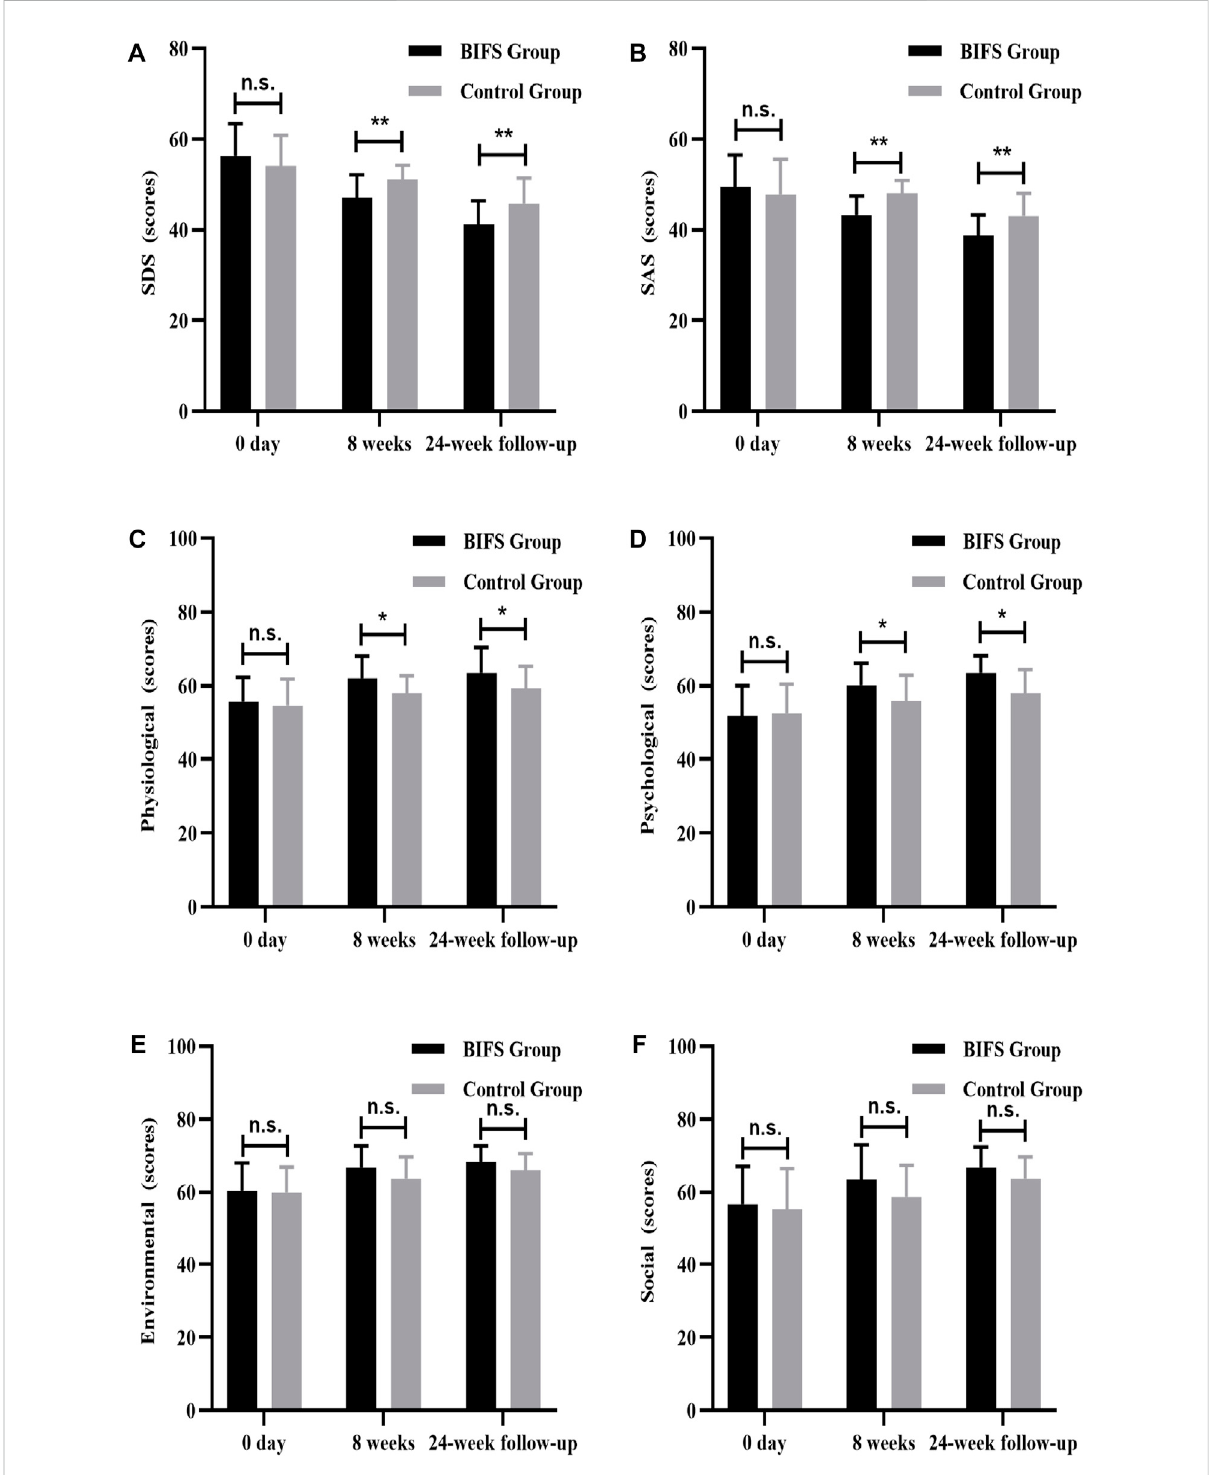
FIGURE 7 Depression, anxiety, and quality of life scores at baseline, after eight treatment weeks, and at 24-week follow-up. (A) Depression score, (B) anxiety score, (C) physiological function score, (D) psychological function score, (E) social function score, (F) environmental function score. n.s., no statistically signi fi cant difference, * p < 0.05, ** p <